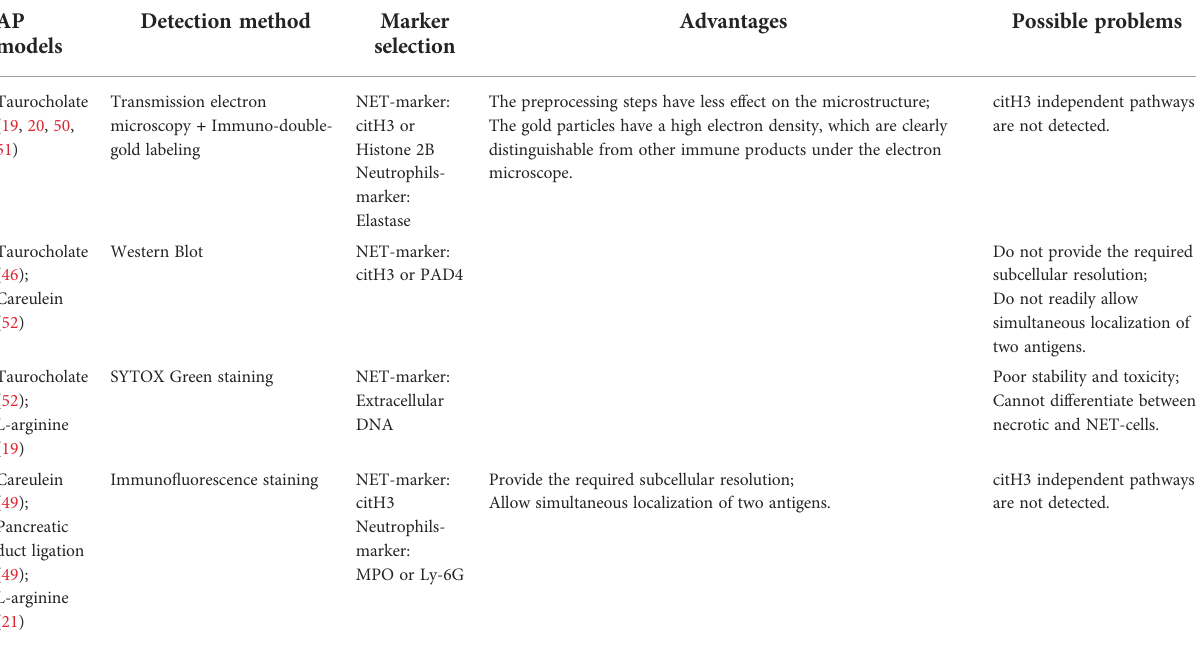
TABLE 1 Detection and visualization of NETs in pancreatic